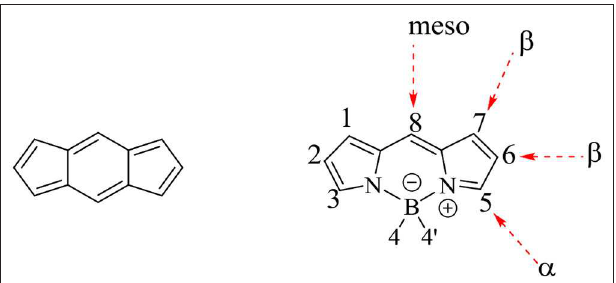
FIGURE 1 | s-indacene and basic BODIPY core